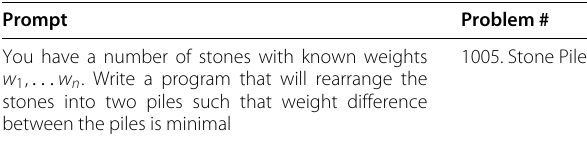
Table 1 An example prompt for programming competition problems and their corresponding problem numbers and